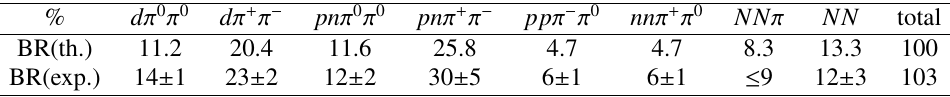
suggests a two-bump structure, fitted in solid red. The lower bump around 300 MeV is perhaps a manifestation of the ABC e ff ect [24], already observed in pn → d π 0 π 0 by WASA-at-COSY [10, 19] and interpreted in Ref. [21] as due to a tightly bound ΔΔ decay with reduced Δ → N π phase space. The upper bump in (a) is consistent then with the d ∗ (2380) → π D 12 decay mode, in agreement with the π d mass distribution shown in (b) that peaks slightly below the D 12 (2150) mass. Table 3. d ∗ (2380) decay width branching ratios (BRs) calculated in Ref. [21], for a total decay width Γ = 75 MeV, are compared with BRs derived from experiment [25, d ∗ (2380)